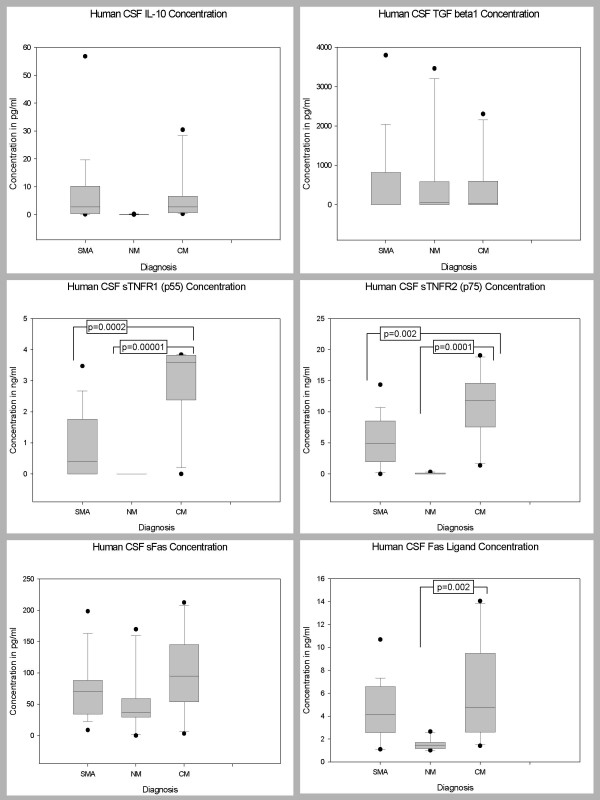
Postmortem CSF biomarker levels of IL-10, TGF-βx, sTNF-R1, sTNF-R2, sFas, and Fas-L in children dying with CM, SMA, NM causes. CM, cerebral malaria; SMA, severe malarial anemia; NM, non-malaria. Box plots representing medians with 25th and 75th percentiles, bars for 10th and 90th percentiles, and points for outliers of biomarker concentrations. Only statistically significant P values after Bonferroni adjustment for the other biomarkers are shown.